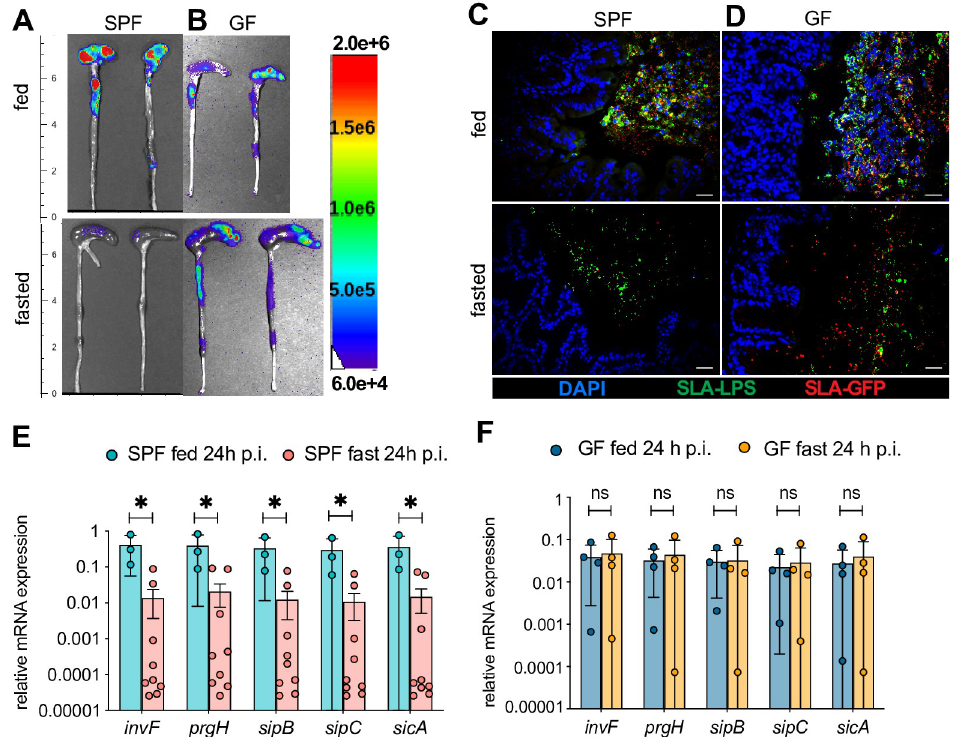
Fig 6. S . Typhimurium is unable to induce SPI-1 in the intestines of fasted SPF mice but retains this ability in GF fasted mice. (A, B) Representative macroscopic ex vivo images of SPF and GF mouse cecum and colon showing magnitude of bioluminescence signal corresponding to expression of the Salmonella SPI-1 invF-luxCDABE transcriptional fusion. Streptomycin-pretreated mice were orally infected with S . Typhimurium carrying the invF- luxCDABE transcriptional fusion in plasmid pCS26- invF , at a dose of ~ 2.5 × 10 8 CFU. Mice were euthanized and intestines imaged at 15h p.i. ± 39h of fasting. Bioluminescence signals were measured in logarithmic units of light (photons/s/cm 2 /sr). (C, D) Representative immunofluorescence staining on paraffin embedded SPF and GF mouse cecal sections at 15h p.i. ± 39h of fasting. Streptomycin-pretreated mice were orally infected with ~ 2.5 × 10 8 CFU S . Typhimurium carrying a plasmid expressing destabilized GFP [GFP(LVA)] under the control of the promoter of the gene encoding the SPI-1 T3SS needle complex protein prgH . Sections were stained using DAPI to detect DNA (blue), anti-Salmonella-LPS (SLA-LPS, green) to visualize total number of S . Typhimurium and anti-GFP to detect prgH - positive Salmonella (SLA-GFP, red). Scale bar 50 μ m. (E, F) Expression of several SPI-1 virulence genes normalized to Salmonella rrsA (16S) gene expression in cecal content of S . Typhimurium infected SPF (E) or GF (F) mice at 24h p.i. ± 48h of fasting, as quantified by ddPCR. For (A, B, D, E) data from multiple independent experiments were pooled. � p < 0.05, ns = not significant. Significance levels calculated by multiple t-test with Holm-Sidak post test. Error bars shown as ± SD. Related to S6 Fig. ( Figs 6A and S6B ). To exclude the possibility that the reduction in luminescence signal (which is oxygen-dependent), in the fasted mice was merely reflective of reduced tissue oxygenation due to the absence of inflammation in the fasted intestines, we infected fed and fasted mice with Salmonella constitutively expressing the Photorhabdus luminescens lux operon on the chromosome. As seen in S6A Fig , the luminescence signal was similar between fed and fasted mice. Furthermore, when quantifying expression of the Salmonella SPI-1 invF-luxCDABE in washed ceca or isolated stool–a process which allows for ample oxygenation–no increase in luciferase signal from the fasted tissues could be detected (S6D and S6E Fig) . These data sug- gest that fasting suppresses the induction of Salmonella ’s SPI-1 program typically seen in the intestines of fed mice and that the observed reduction in luciferase signal in fasted mice was not due to decreased oxygen availability.